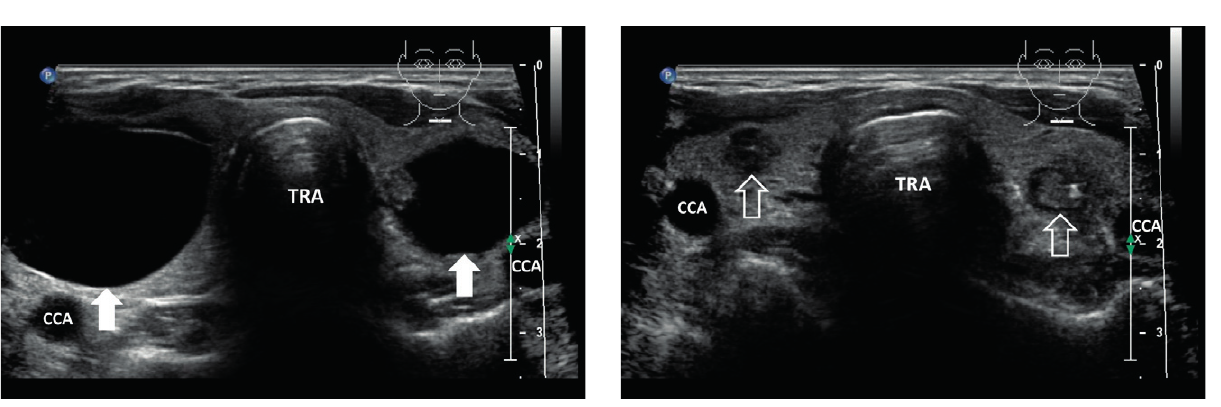
Fig. 3a. A 35–year–old woman with three years palpable resis- tance on the neck. US scan prior to PEIT showed multinodular goiter with two complex cysts (full arrows), in the right lobe size 45 × 35 × 20 mm and volume 16 mL, in the left lobe size 35 × 20 × 15 mm and volume 6 mL, (fluid recurrence after two resp. one evacu- ations of brownish liquid): smooth wall, only in the small cyst focally hyperechoic thick wall, anechoic contents; transverse.